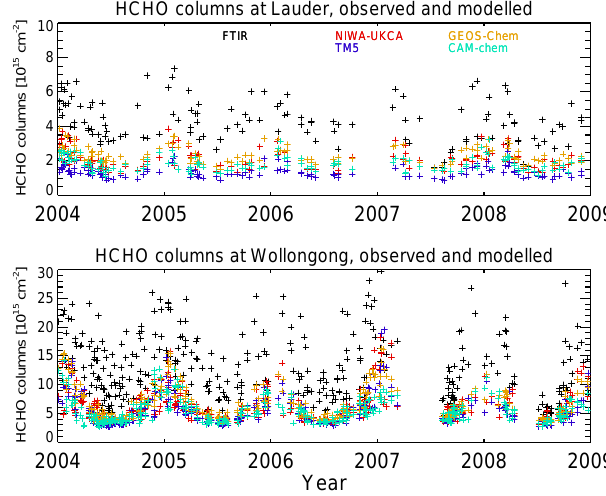
Figure 9. Modelled and observed daily-mean FTIR HCHO columns at Lauder and Wollongong. Simulations use CLM-MEGANv2.1 biogenic